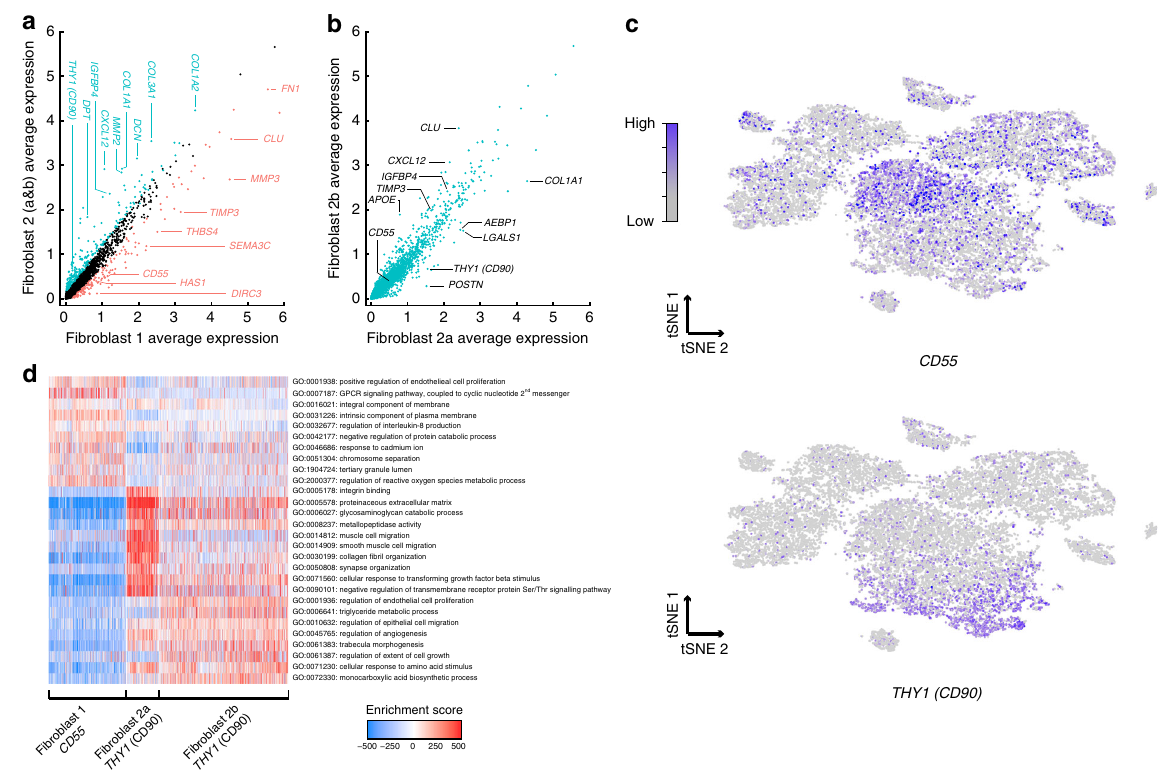
Fig. 4 Identi fi cation of synovial fi broblast subtypes. a Bulk expression ( ‘ in silico average ’ ) comparison of fi broblast populations (1 vs. 2a&b combined across all patients). Genes up-regulated in fi broblast population 1, based on differential expression analysis with Bonferroni-corrected p < 0.05, are indicated in red and genes expressed predominantly in fi broblast population 2 are indicated in teal. b Expression comparison across fi broblast sub-populations 2a and 2b. c CD55 (top) and THY1 (CD90) (bottom) expression across the global tSNE. d Pathway and gene set overdispersion analysis on the three fi broblast populations identi fi ed from unbiased clustering of single cell RNA-seq data from patient RABP3. Enrichment score corresponds to each cells ’ fi rst principle component loading from pathway analysis as computed in